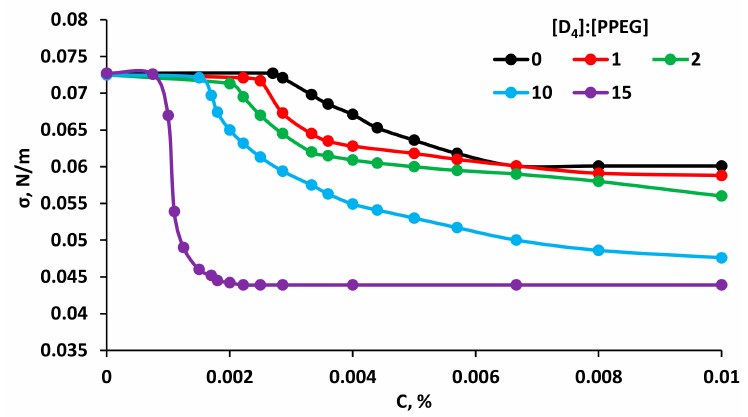
Figure 5. Surface tension ( σ , N/m) isotherms of MBC.